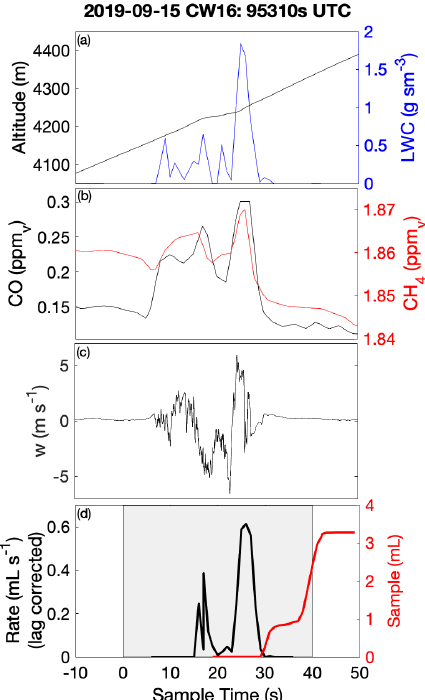
Figure 1. Example CW sample merge with auxiliary data for a con- vective cloud penetration. Time series of (a) altitude and merged LWC, (b) CO and CH 4 gas tracers, (c) vertical velocity, and (d) AC3 diagnostic accumulated sample water (right) and estimated lag- corrected collection rate (left). The shaded region indicates the sam- pling duration, when the AC3 shutter was open, noting that the physical collection of CW within the system can continue for a short duration